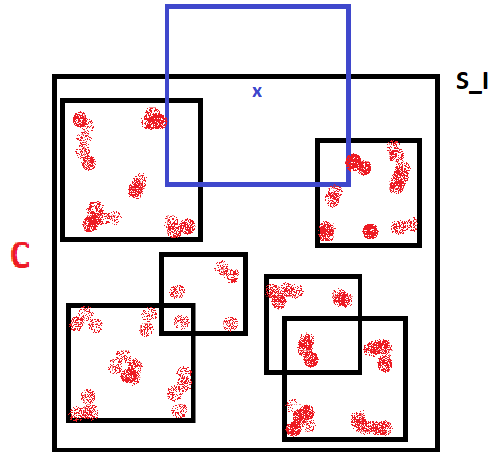
Figure 10. The radius h I of the blue square is the substitute of the notion of the gap size. Definition 6 (Thickness of C associated with the system of cubes { S I } I )